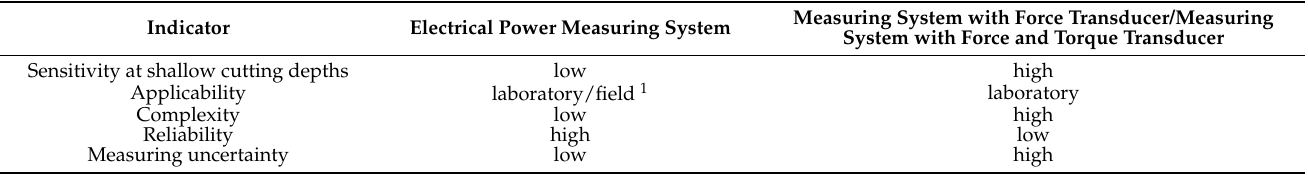
Table 5. Comparison of measuring